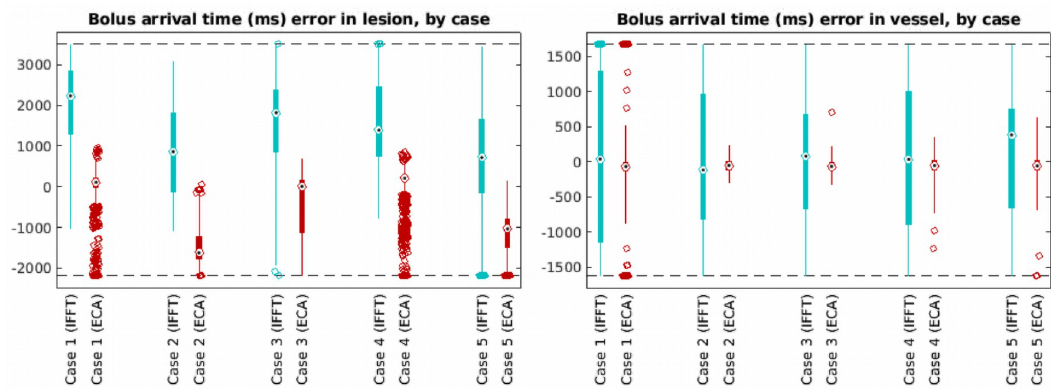
Fig 8. Box and whisker plots of the error in bolus arrival time, by case number and reconstruction method. Red boxplots (right) are from ECA-reconstructed data; blue boxplots (left) are from standard IFFT reconstructions. Separate sets of plots are shown for lesion and vessel